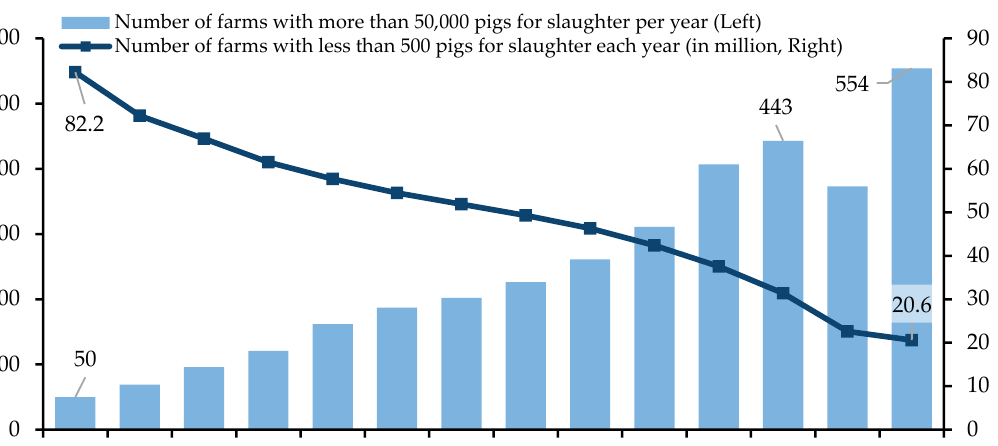
Figure 1. Number of Pig Farms in China from 2007 to 2020. (Source: China Animal Husbandry and Veterinary Yearbook.).